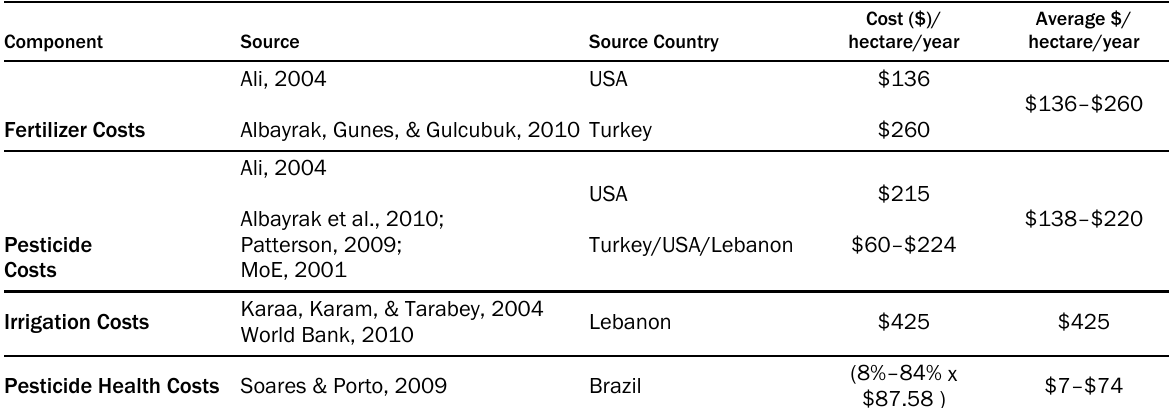
Table C1. Estimated Input Costs for Small-Scale Sugar Beet Production in Lebanon Component Source Source Country